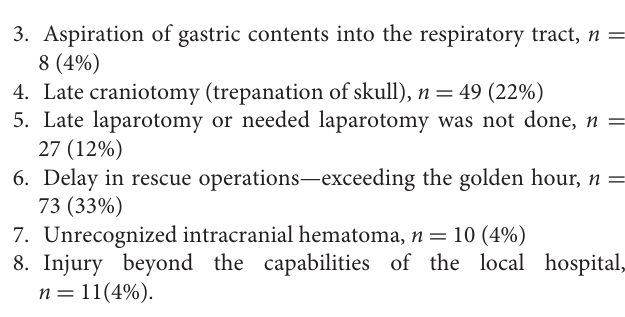
position or a flight of stairs